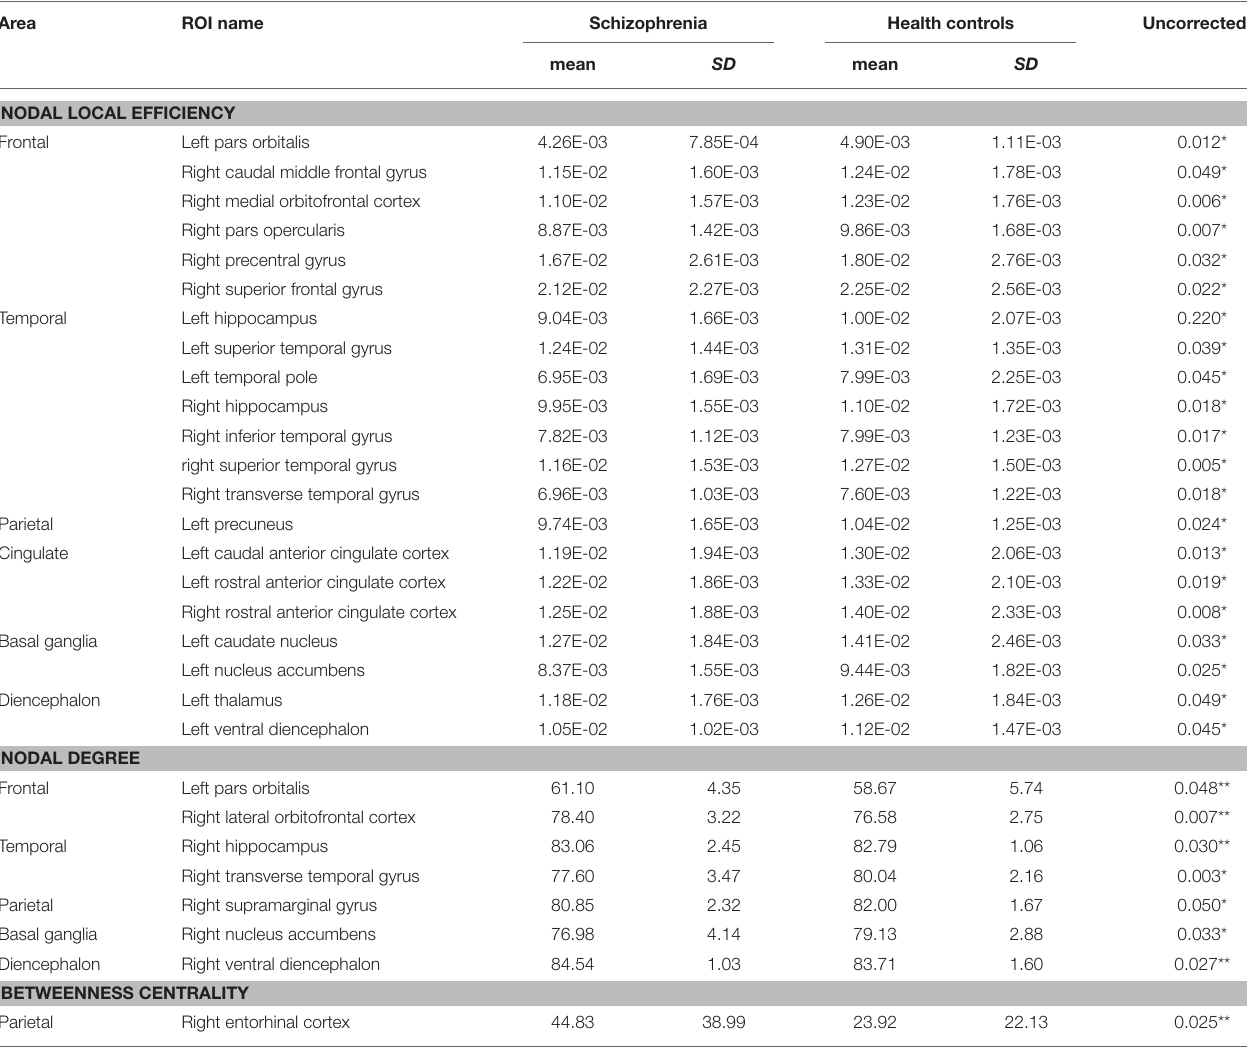
The Mann-Whitney U test was used for all statistical comparisons. * healthy control > schizophrenia. ** schizophrenia > healthy